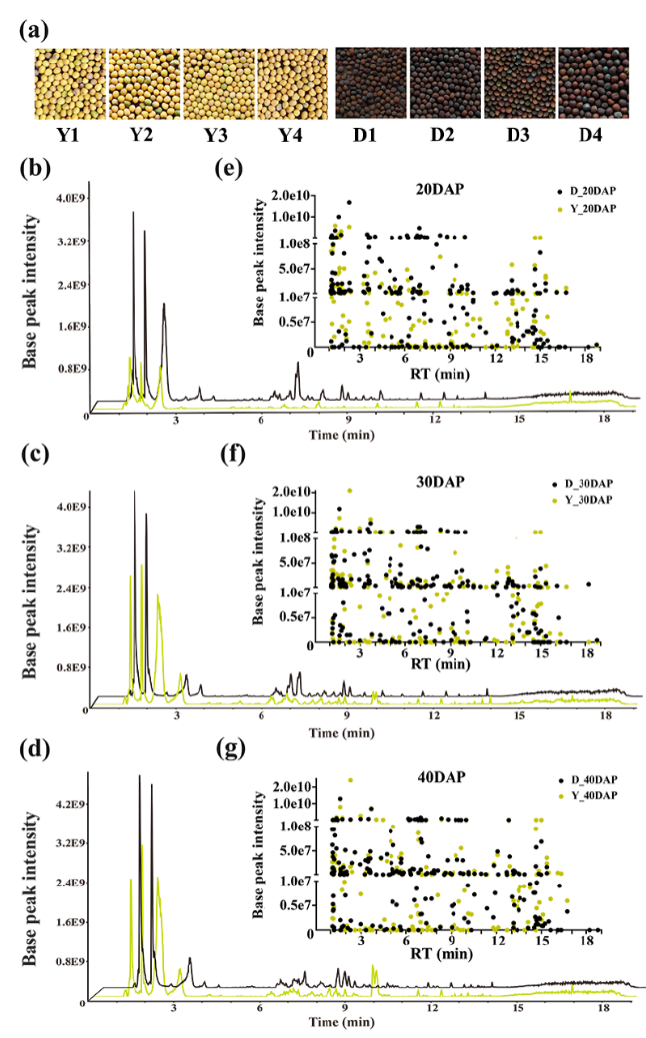
Figure 1. MS data analysis in yellow- and dark-seeded B . juncea . ( a ) Seed coat color of yellow- and dark-seeded B . juncea . ( b–d ) Base peak chromatograms of seeds under full scanning ( m / z = 100–1500) at 20, 30, and 40 days after pollination (DAP), respectively. The black and green lines indicate dark- and yellow-seeded B . juncea , respectively. ( e–g ) All of the detected compounds were generated from seeds at 20, 30, and 40 DAP, respectively. The green and black dots represent compounds from yellow- and dark-seeded B . juncea , respectively. The horizontal and vertical coordinates represent the retention times (RTs) and peak areas of the corresponding compounds,